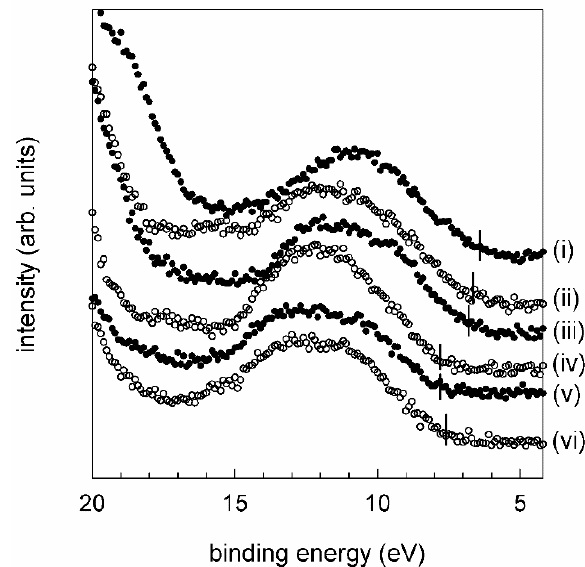
Figure 3. Total and partial DOS for BaTaO 2 N as calculated using linear muffin-tin orbital (LMTO) code.